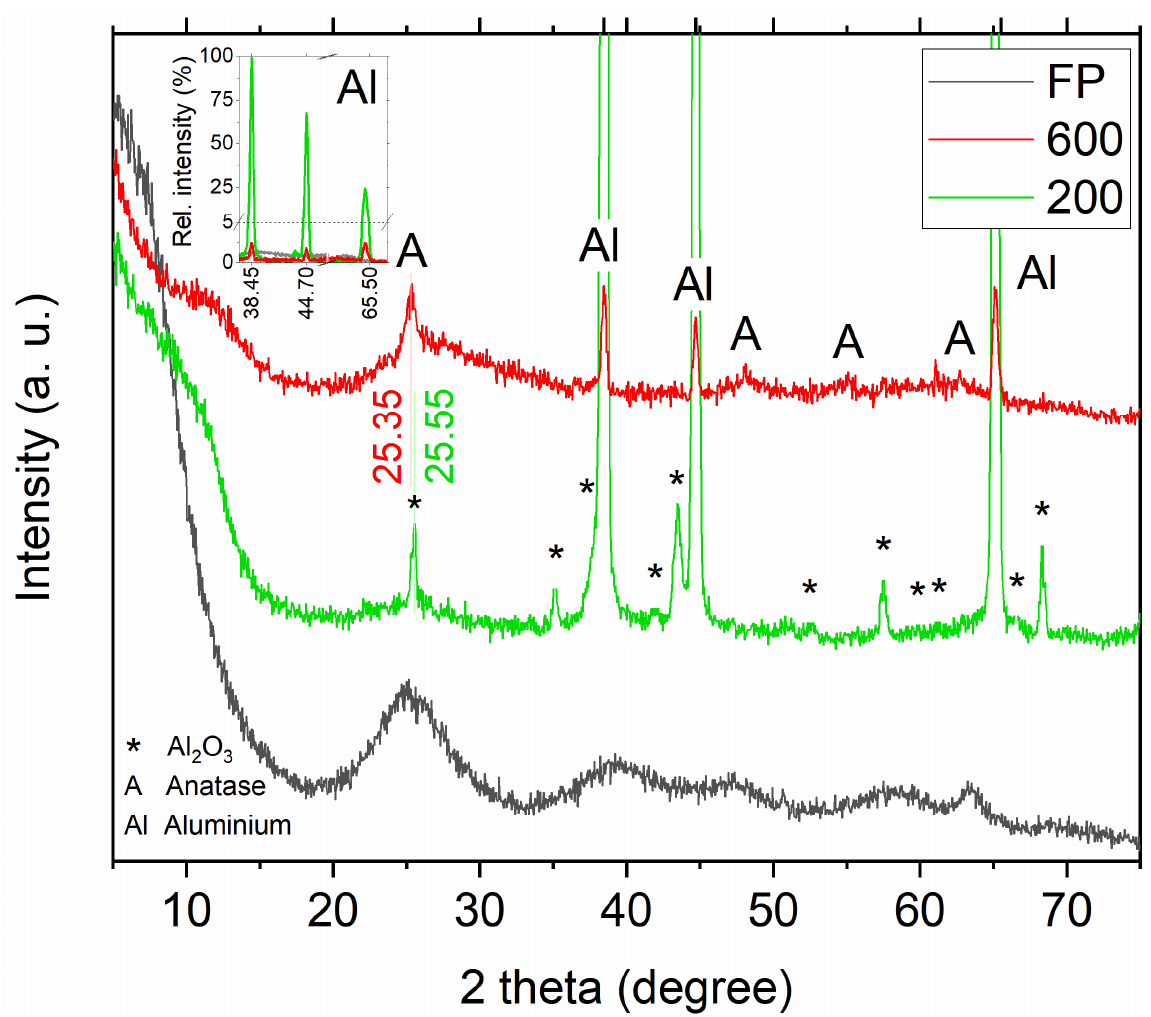
Figure 1. X-ray diffraction patterns of feedstock powder (black), sample 200 (green) and 600 (red).